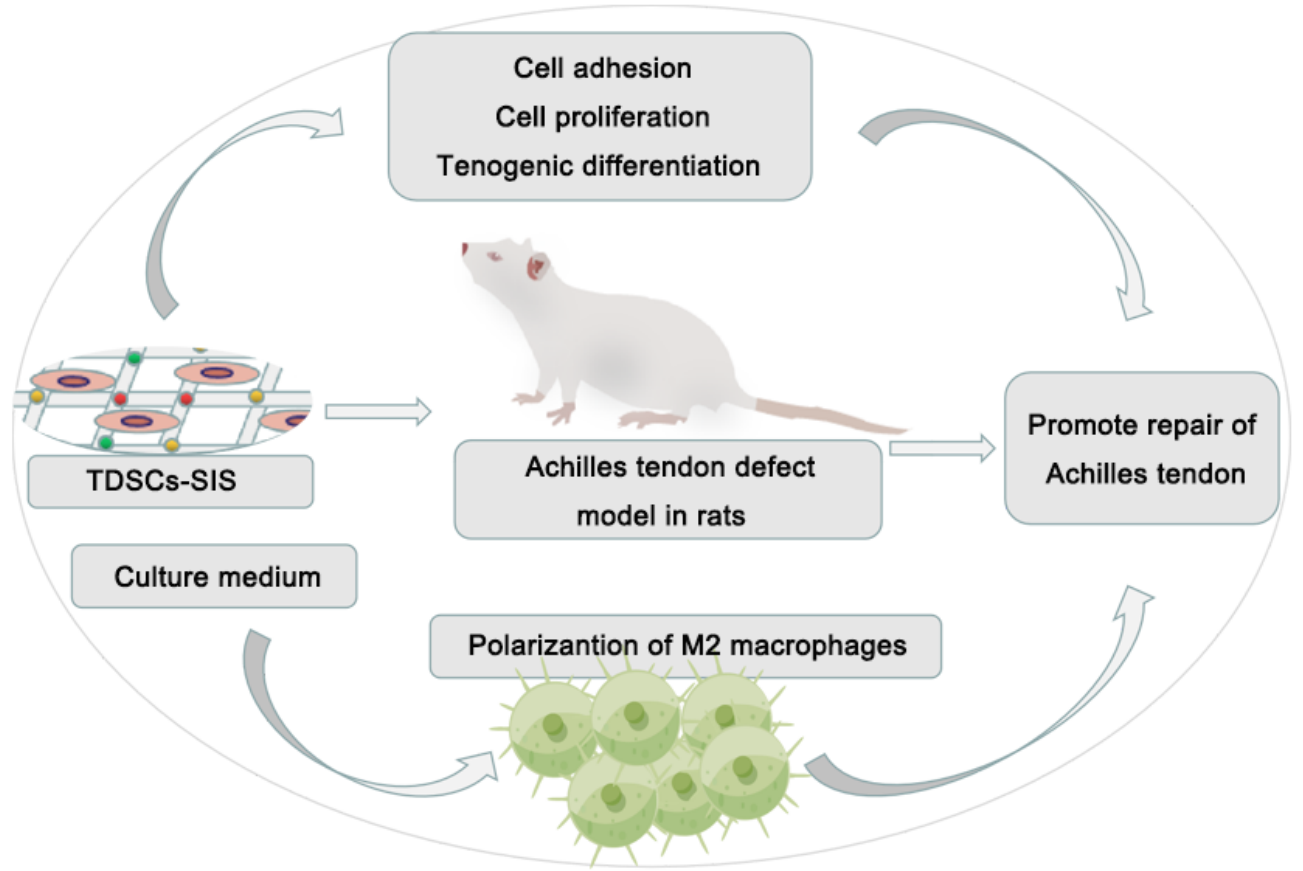
Figure 8. Summary illustrations for TDSCs – SIS in in vitro and in vivo assessments. In vitro SIS pro- moted the adhesion, proliferation, and tenogenic differentiation of TDSCs, while the culture media of TDSCs – SIS promoted the polarization of M2 macrophages. In vivo TDSCs – SIS scaffold promoted the regeneration of Achilles tendon. The synergy of in vitro and in vivo work together to promote repair of the Achilles